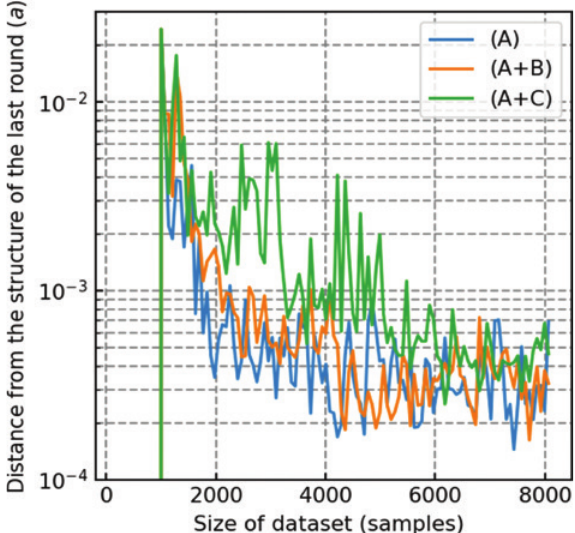
Figure 5: Inter-structure distances between the structure with the highest Q factor in the present round (at and that in the previous rounds (at the dataset. The inter-structure distance ' | | modifications in each round of optimization are. The results for the three different strategies (A), (A + B), and (A + C) are shown with blue, orange, and green curves, respectively.